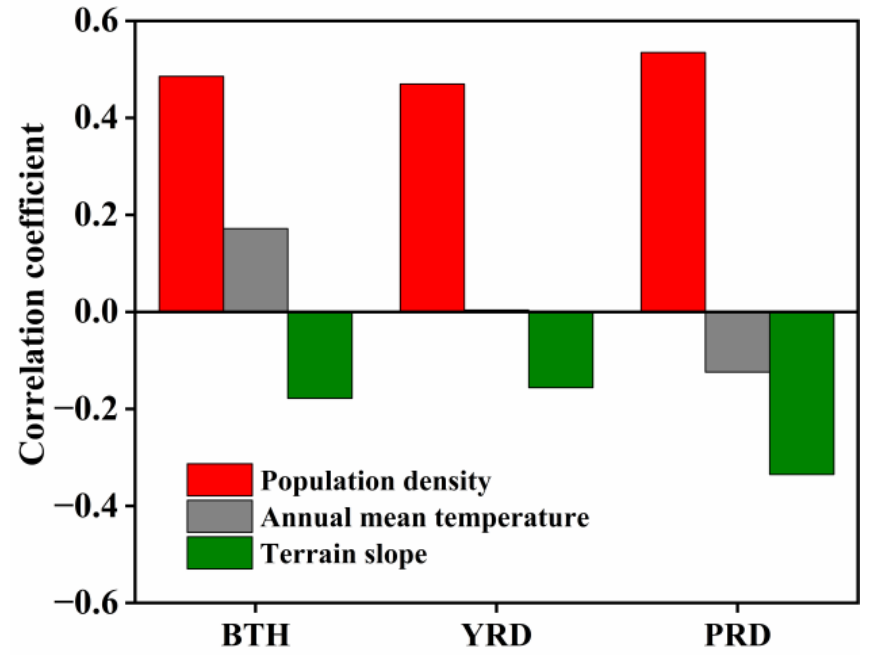
Figure 9. Profiles of CO 2 emissions along urbanization gradients in: ( a ) Beijing; ( b ) Langfang of Beijing-Tianjin-Hebei (BTH); ( c ) Shanghai; ( d ) Chizhou of Yangtze River Delta (YRD); ( e ) Guangzhou; and ( f ) Zhaoqing of Pearl River Delta (PRD).